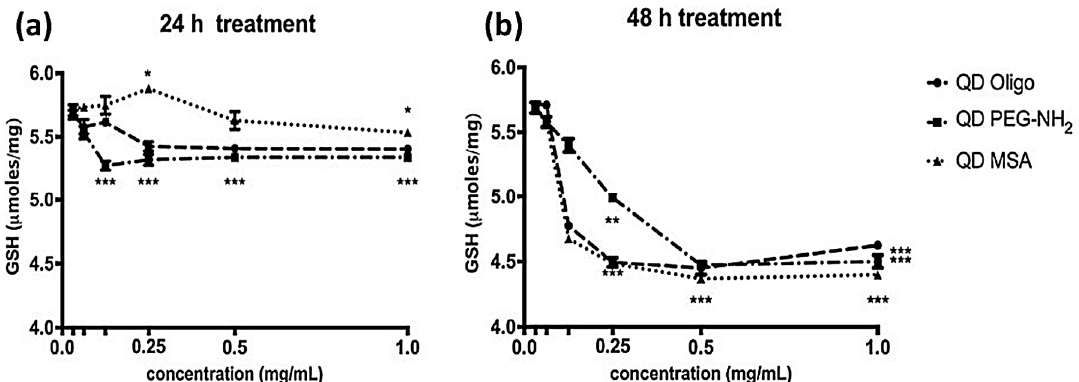
Figure 6. GSH protein levels in RAW 264.7 cell extracts after treatment with QDs Oligo, PEG-NH 2 , and MSA for ( a ) 24 h and ( b ) 48 h ( n = 2). Data is presented as mean ( µ moles/mg) SEM with * ( p < 0.05), ** ( p < 0.01), and *** ( p < 0.001).